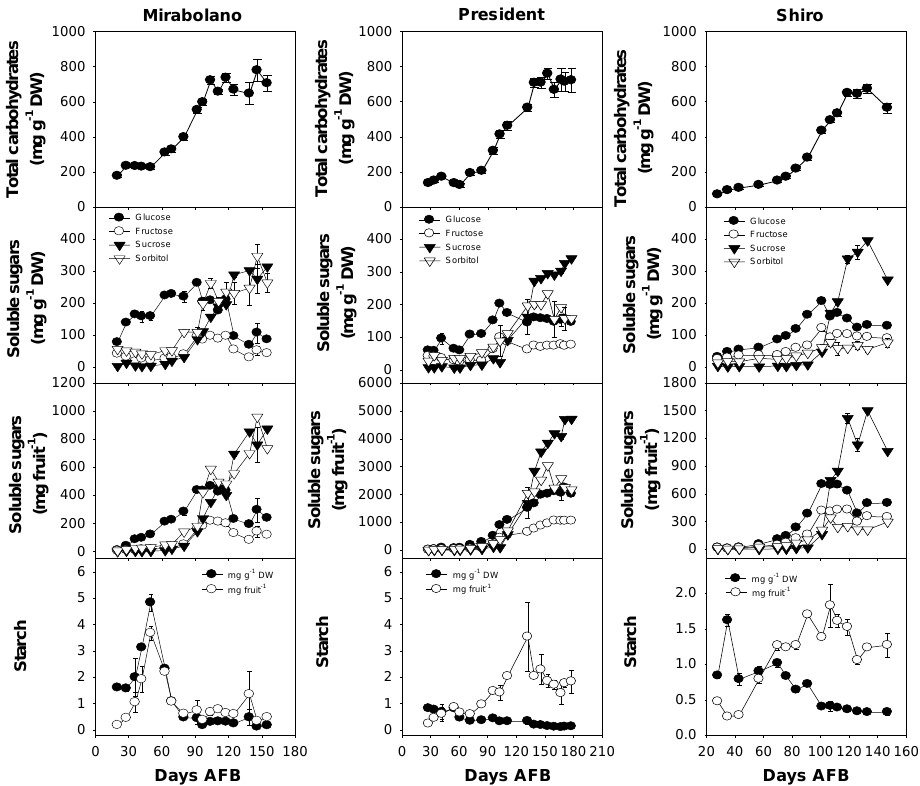
Figure 3. Soluble carbohydrate contents of the flesh (mesocarp + epicarp) of fruits of Prunus cerasifera —Mirabolano, Prunus domestica —cultivar President, and Prunus salicina —cultivar Shiro at different stages of development. Each point on the graph shows the mean and standard error, n = 3. AFB = after full bloom.